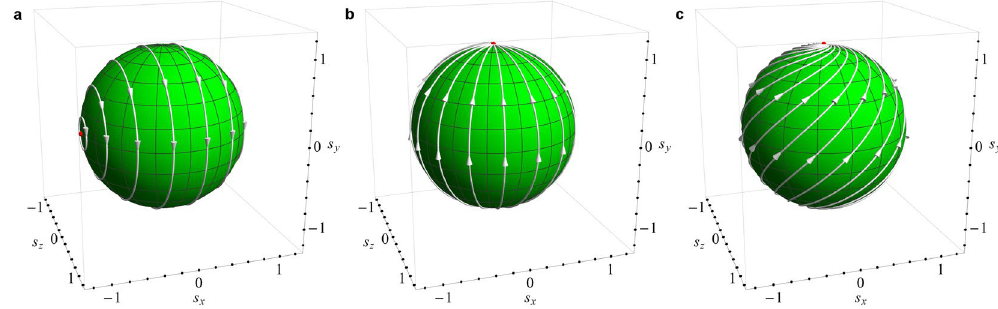
Figure 1. Geodesics of an elliptic ( a ), hyperbolic ( b ), and loxodromic ( c ) Möbius transformation, corresponding in spin dynamics to the applied real magnetic field along the x axis ( a ), imaginary magnetic field along the y axis ( b ), and complex magnetic field along the y axis ( c ).